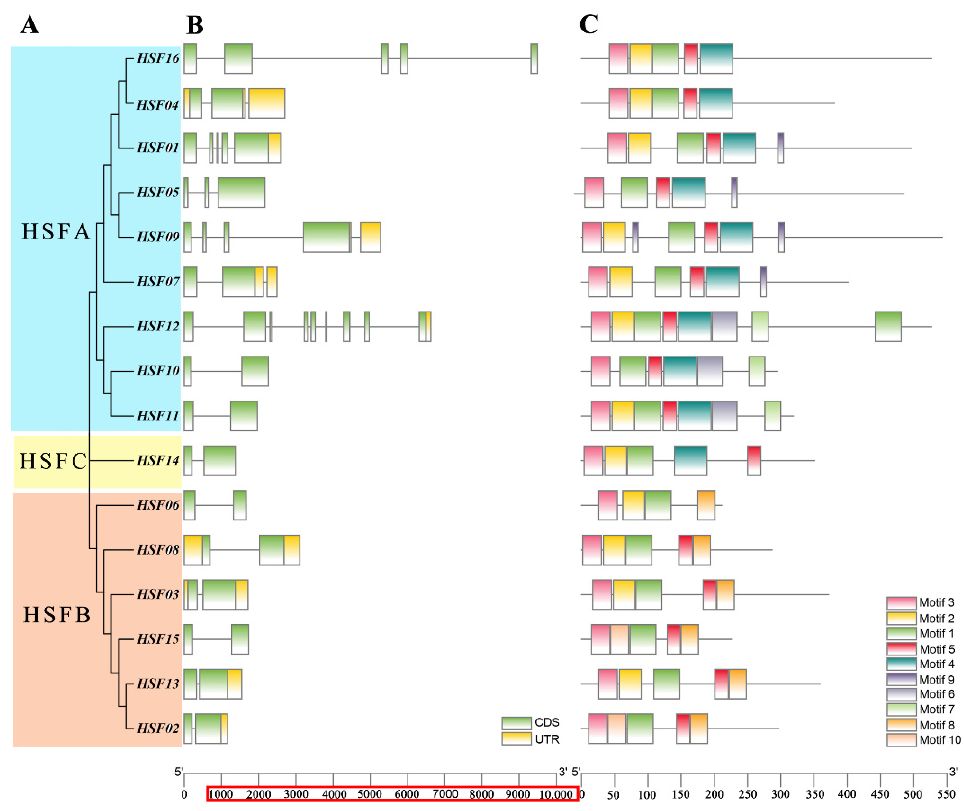
Figure 4. Phylogenetic relationship tree ( A ), gene structure ( B ) and conserved patterns ( C ) of HSF in M. sativa.